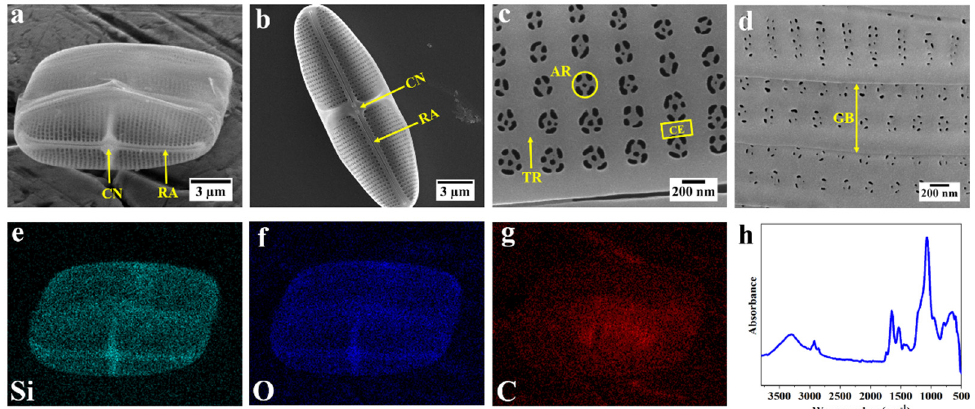
Figure 1. Morphology and elemental composition of the frustule of diatom C.sp. ( a – d ) SEM images of frustule of C.sp. ( a ) intact frustule of C.sp. ; ( b ) an isolated valve deposited on its concave orientation showing the interior surface of the valve (RA = raphe; CN = central nodule); ( c ) porous area of the valve (TR = transapical rib; CE = cross extension; AR = areola); ( d ) overlapping girdle bands (GB); ( e – g ) EDS elemental mapping of the intact frustule; green = silicon, blue = oxygen, red = carbon; ( h ) FTIR spectra of frustule of C.sp.